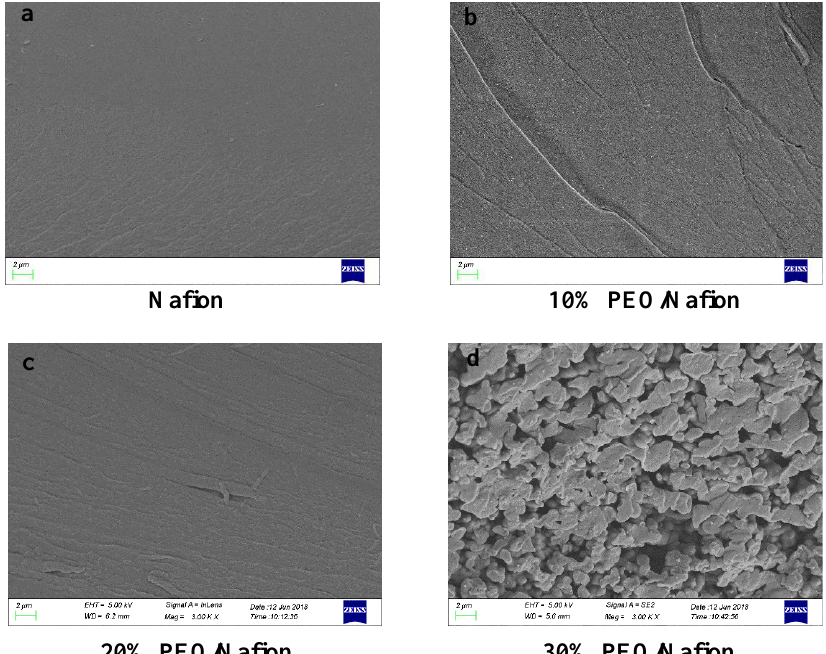
Figure 2. The cross − sections of Nafion membranes with PEO contents of ( a ) 0 wt%, ( b ) 10 wt%, ( c ) Figure 2. The cross-sections of Nafion membranes with PEO contents of ( a ) 0 wt%, ( b ) 10 wt%, 20 wt% and ( d ) 30 wt%, respectively. ( c ) 20 wt% and ( d ) 30 wt%, respectively.